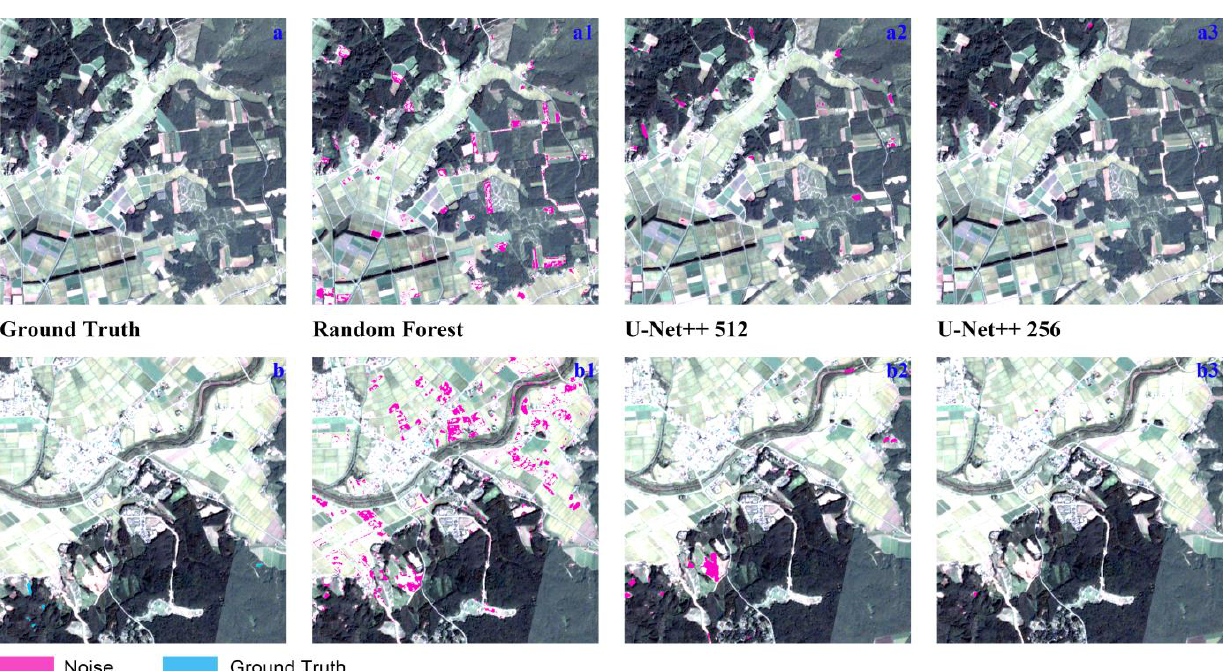
Figure 10. Comparison of the model ’ s sensitivity to noise. a and b represent two subplots in the results that contain noise (e.g. buildings, bare soil, roads, etc.), 1 represents the result of random forest, 2 represents the result of U − Net ++512, and 3 is the result of U − Net ++256. To further analyze the results of RF and U − Net++, four sub − regions were selected for detailed comparison. As shown in Figure 11, the peach area is the landslide area identified by three models, and the red polygon represents the manual interpretation of the land- slide area. It showed that the U − Net++ predicted the interior and boundary of landslides more completely. In addition, both RF and U − Net++256 recognized large landslides in the four regions, while U − Net++512 missed some landslide regions in Figure 11 b2. It can be seen from Figure 1 that RF was prone to misclassify the pixels, which have similar spectral characteristics to landslides. In Figure 12, the yellow and green areas represent the FN and FP parts of the confusion matrix, respectively. This indicated that U − Net++256 obtained less FP and FN compared to RF and U − Net++512. Overall, the identified landslides of U − Net++256 were more complete.